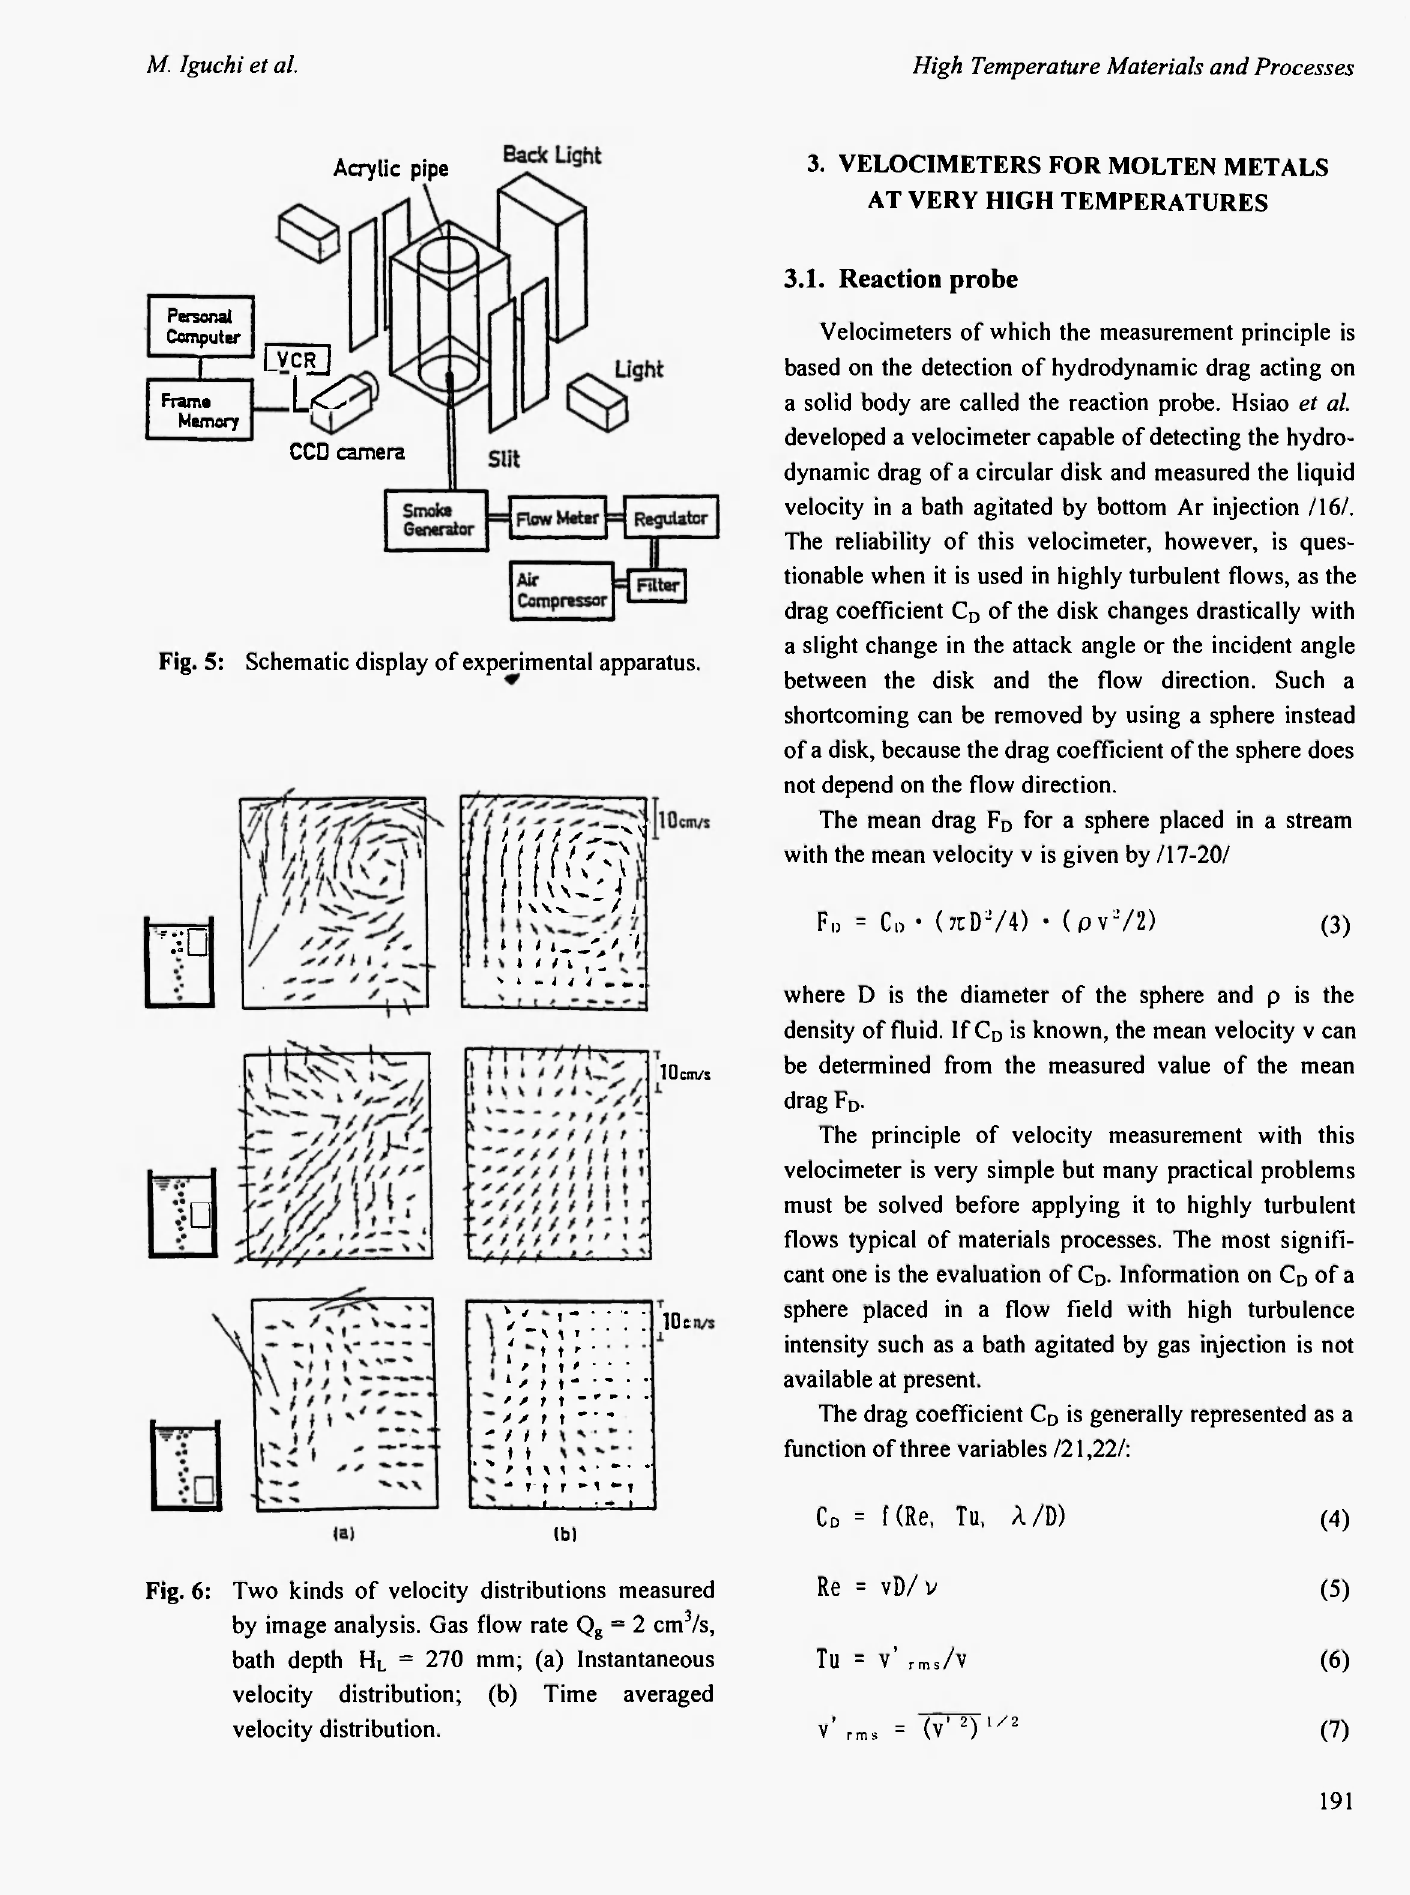
Fig. 6: Two kinds of velocity distributions measured by image analysis. Gas flow rate Q g = 2 cm 3 /s, bath depth H L = 270 mm; (a) Instantaneous velocity distribution; (b) Time averaged velocity